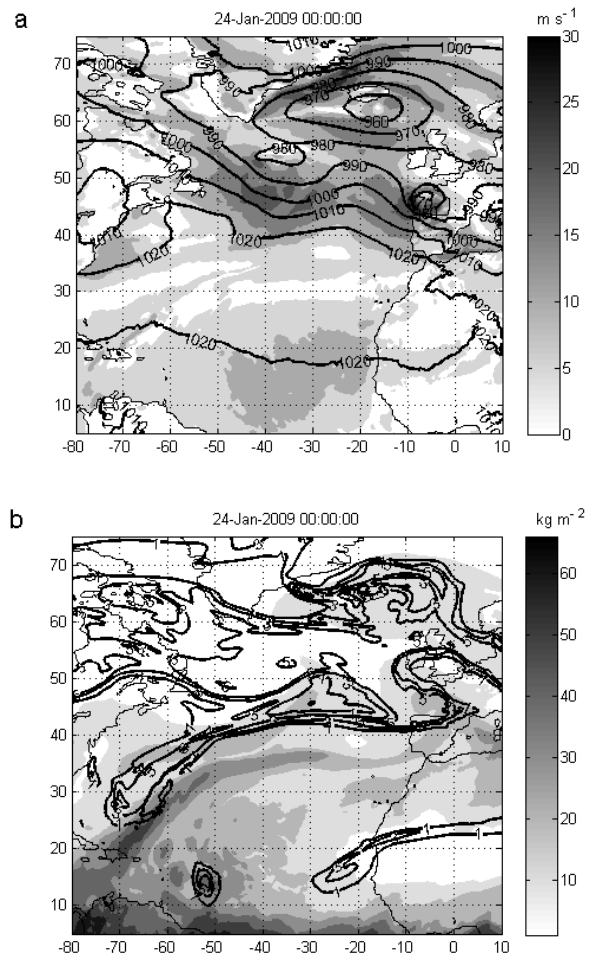
Figure 2. As Figure 1, but at 00 UTC